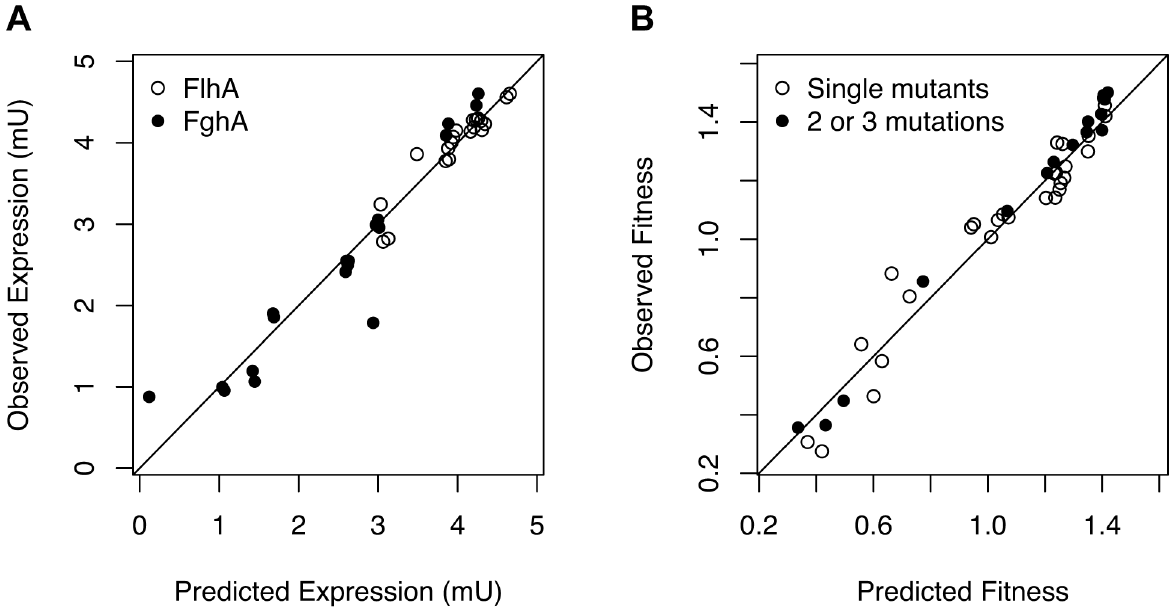
Figure 3. Mutations exert independent effects upon enzyme expression but a mechanistic model of benefits and costs of enzymes is required to predict combined effects on fitness. A) Expression levels (in mU) are well predicted by independent, multiplicative effects of each mutation on the FlhA and FghA enzymes. B) Using a kinetic model of catalysis and costs parameterized with data from the single mutants and inducible promoter constructs predicts the mutational combinations very well (R 2 =0.98).